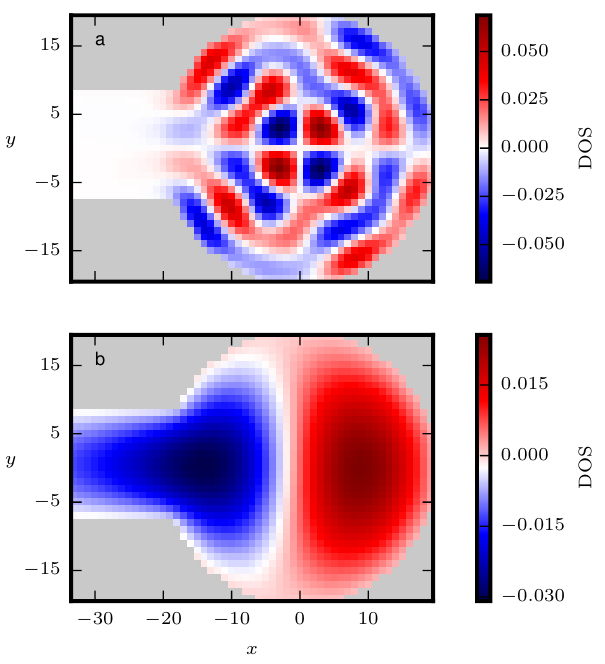
Figure 5: Real part of the wavefunction for two bound states of the billiard of Fig. 4. The parameters correspond to the white and bicolor circles (a) and (b) of Fig. 4. State (a) is a bound states that coexists with the continuum. State (b) was selected at an energy below (but